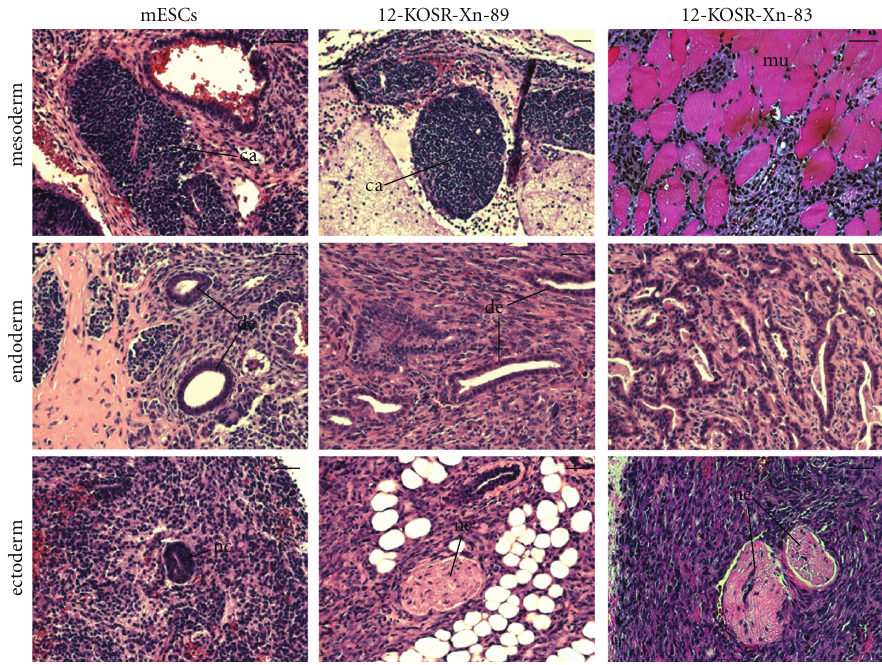
Figure 6: Reprogrammed cell clones derived from SACK-D pancreatic stem cell strain mPanstra-12 form teratomas in immunodeficient mice. Shown are micrographs of hematoxylin-and-eosin-stained tissue sections from subcutaneous tumors formed from mESCs or reprogrammed 12-KOSR-Xn-89 (AP+) and 12-KOSR-Xn-83 (AP − ) cell clones. The corresponding embryonic germ layer of each histological example is indicated. ca, cartilage; mu, muscle; de, digestive tract epithelium; nc, neurectoderm; ne, nerve. Scale bars = 50 μ m.